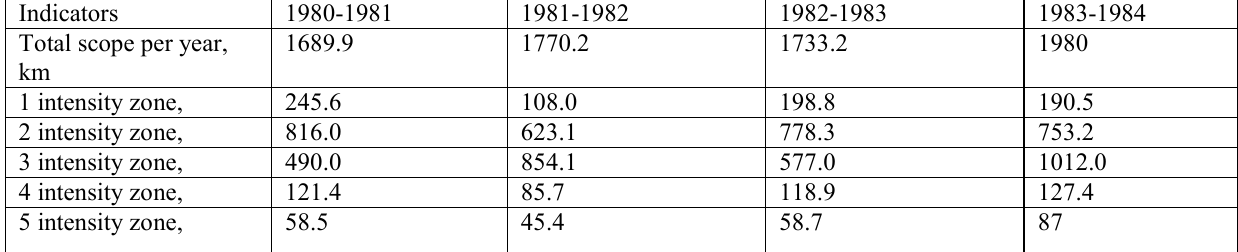
Total scope and intensity in % from “max” of S. Kopchikova